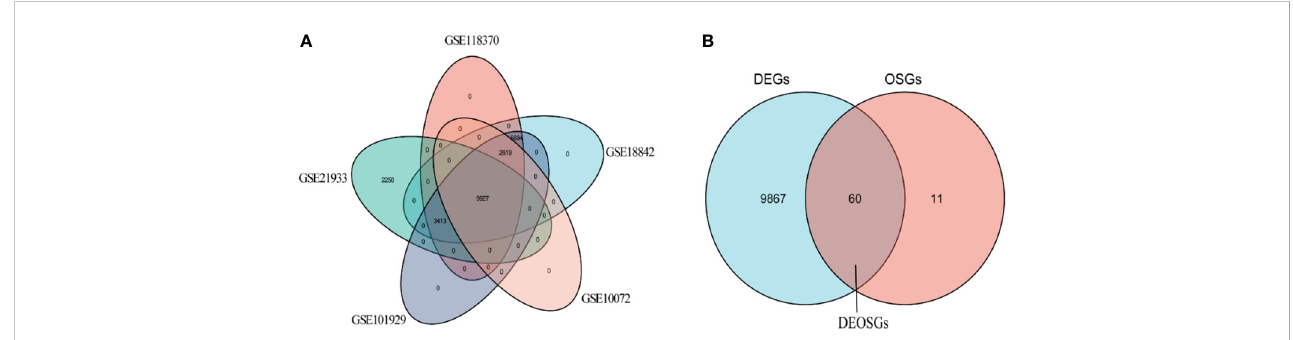
FIGURE 3 Venn diagrams for screening of (A) DEGs and (B) DEOSGs.